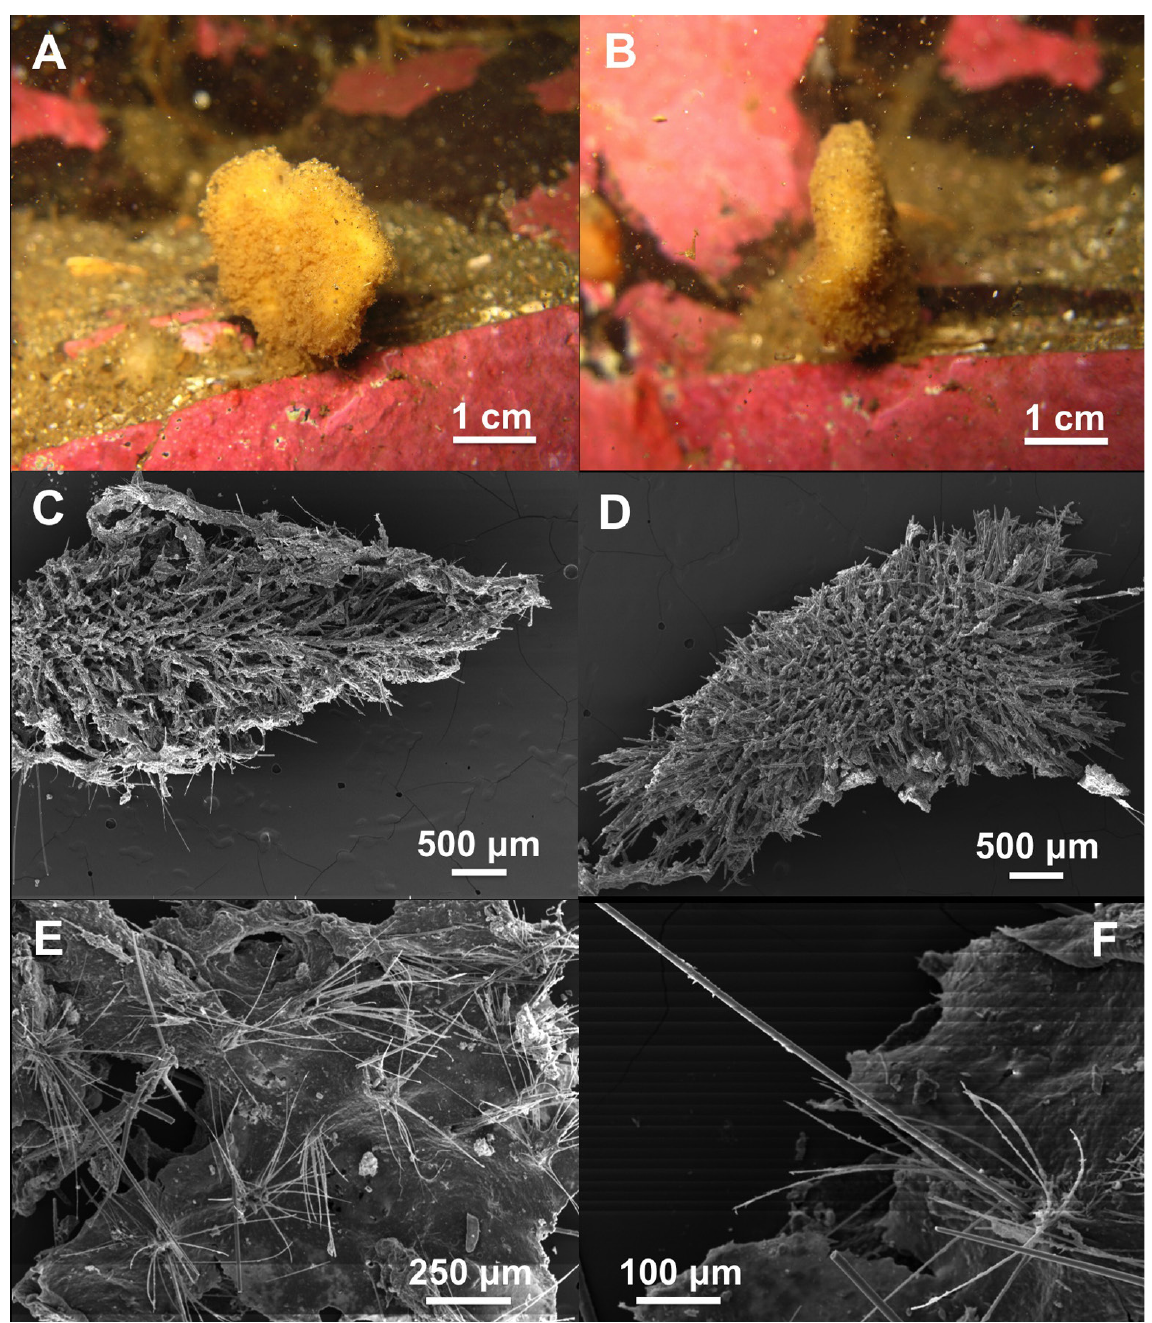
Fig. 5. Axinella coronata Bertolino, Costa & Pansini sp. nov., holotype (CILE 22; MSGN 61494). A – B . The holotype in life. C . Plumose multispicular skeleton. D . Cross section of the skeleton. E . Ectosome. F . Magnification of a single tylostyle, surrounded by a crown of thin